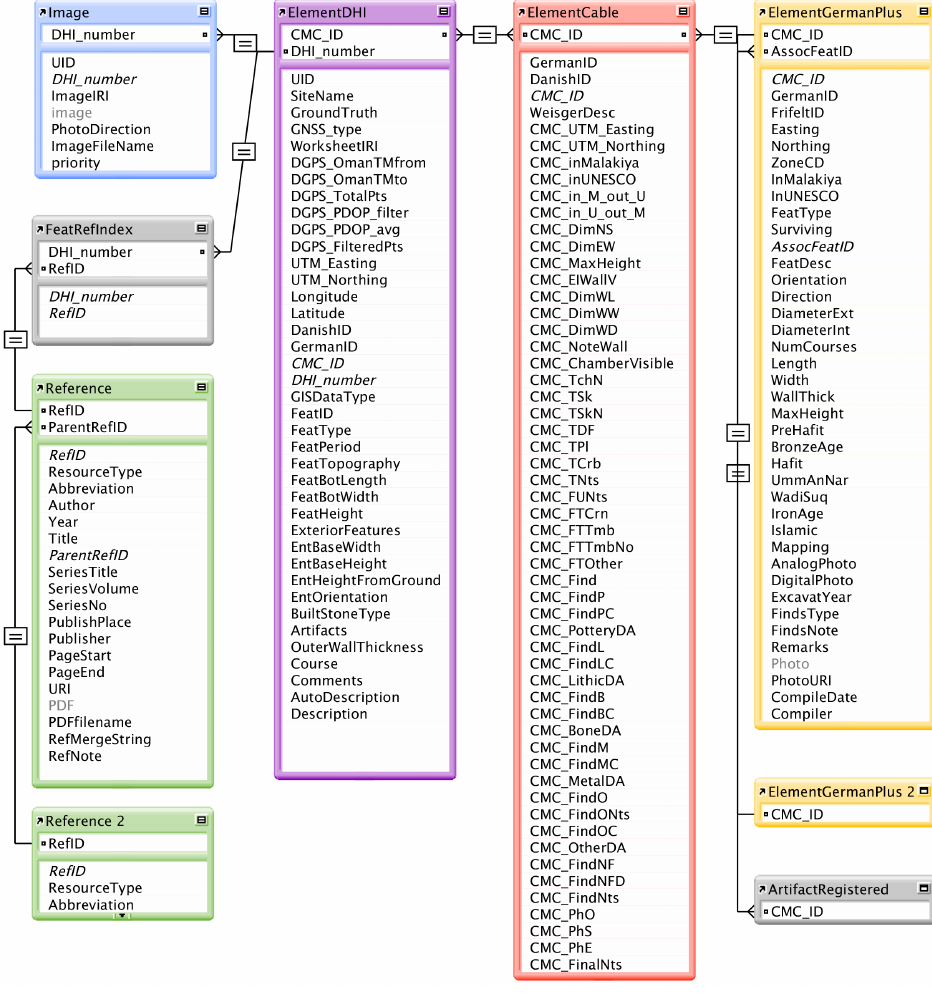
Figure 3: Entity-relationship diagram of BatDHI. See Cable 2012 for the description of fields in the ElementCable table.